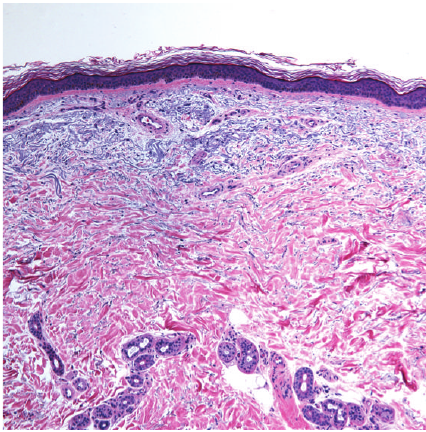
Figure 3: Histopathological examination of acquired brachial cuta- neous dyschromatosis. Note the pronounced atrophy of the viable epidermis and papillary dermis, increased telangiectasias, abundant solar elastosis, and scattered melanophages, consistent with ABCD 100x magnification,